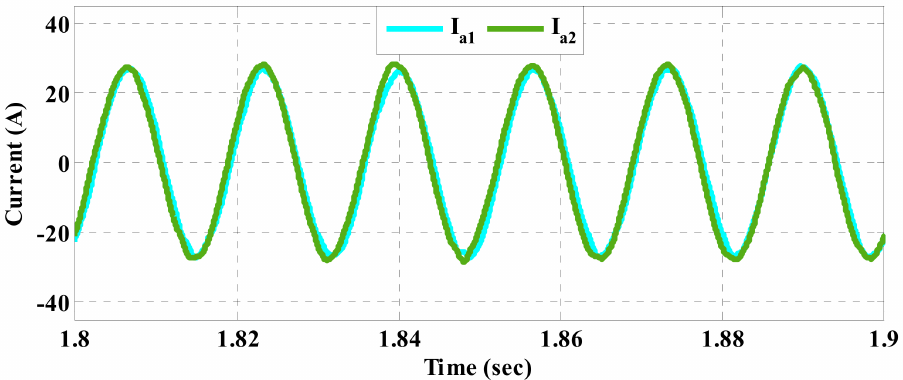
Figure 14. Injected currents of DGs to the microgrid based on the conventional control method.